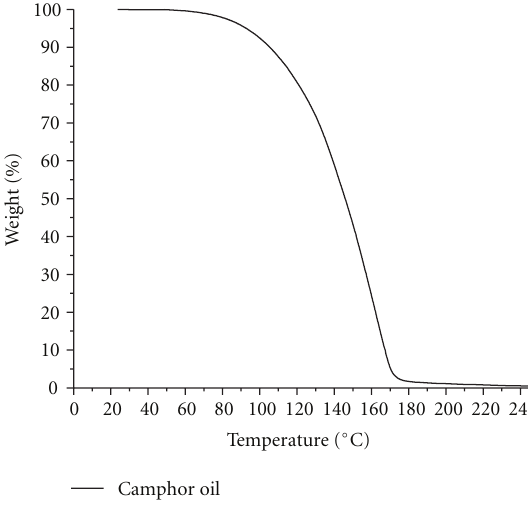
Figure 3: TG analysis of camphor oil.